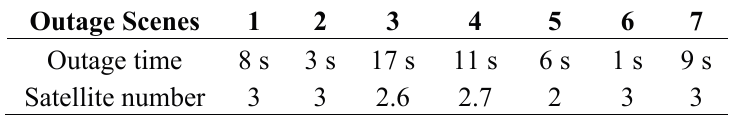
Figure 10. Vehicle-borne satellite availability ( top ) and the GPS outages situations ( bottom , a shows urban canyon with high and big buildings; b is under foliage shade; c is under an overpass), on 7 January 2012 in Wuhan, China. Table 5. The GPS outage time last and available GPS satellite